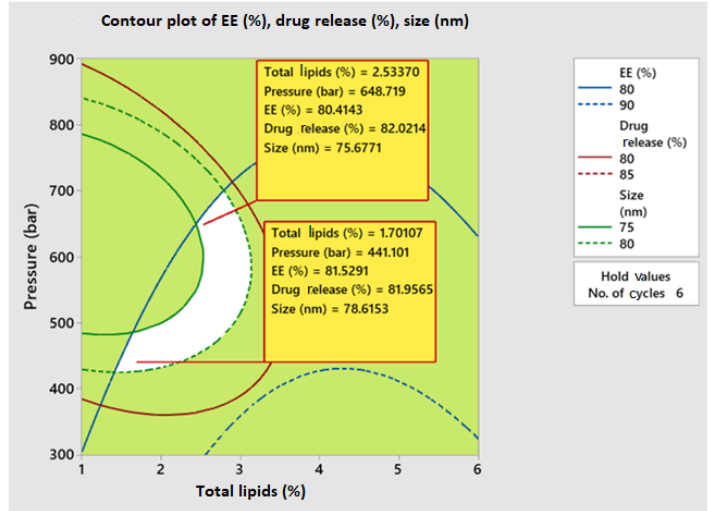
Figure 8. Overlay contour plot indicating design